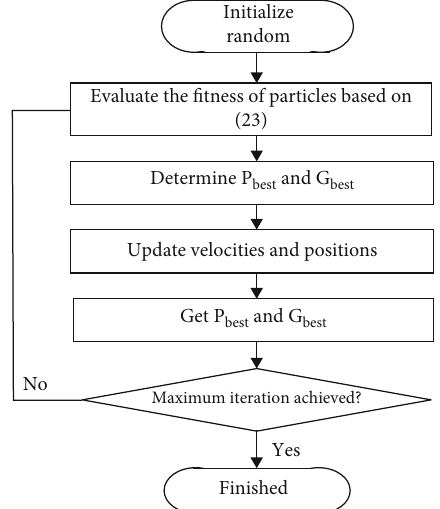
Figure 9: Simulink/MATLAB model of PSO-based PMSM sensorless control.